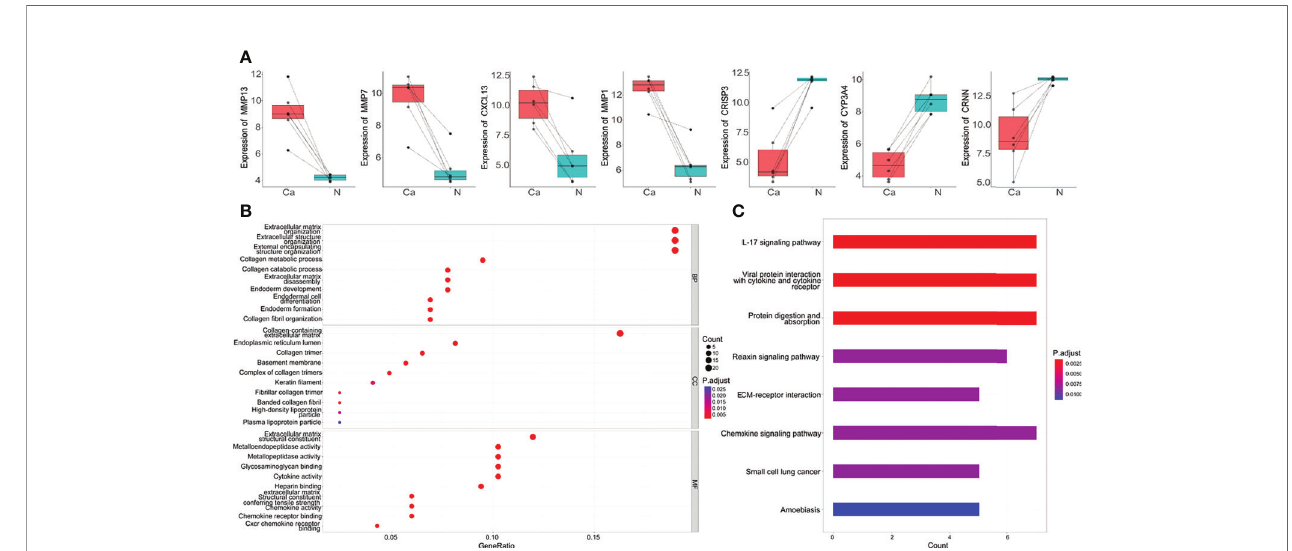
FIGURE 2 | The top DEGs and common DEGs enrichment analysis results. (A) The expression of seven DEGs in microarray dataset GSE138206. Ca, cancer; N, Normal. (B) The enrichment analysis results of GO database with BP, CC and MF. (C) The enrichment analysis results of KEGG Pathway. Adjusted P-value < 0.05 was considered signi fi